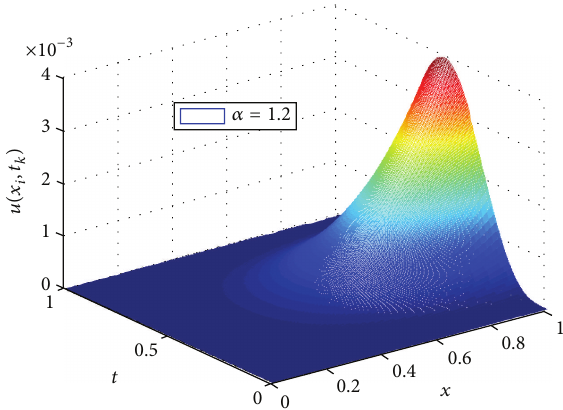
Figure 3: The numerical solution surface when 𝛼 = 1.2 in Example 3 (𝜏 = 1/500, ℎ = 1/100) .